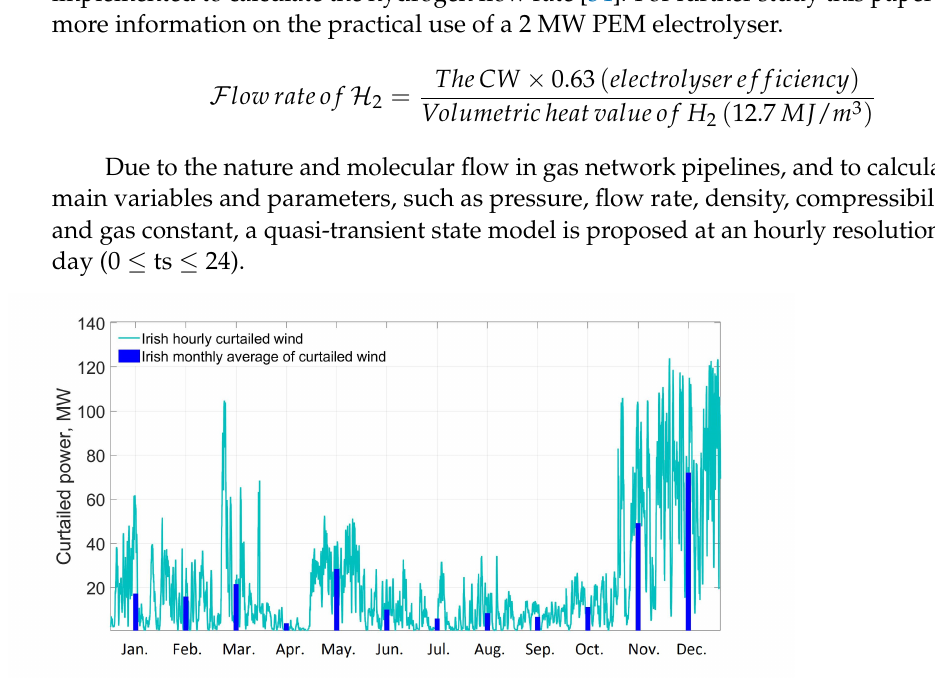
Figure 4. Curtailed wind profile in Ireland.